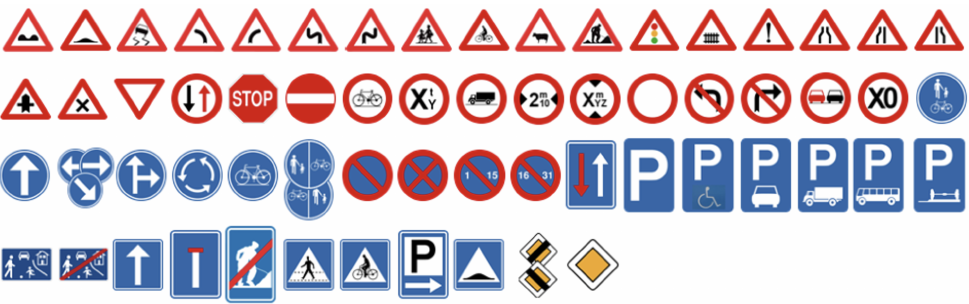
Figure 3. Belgium traffic sign (BelgiumTS)